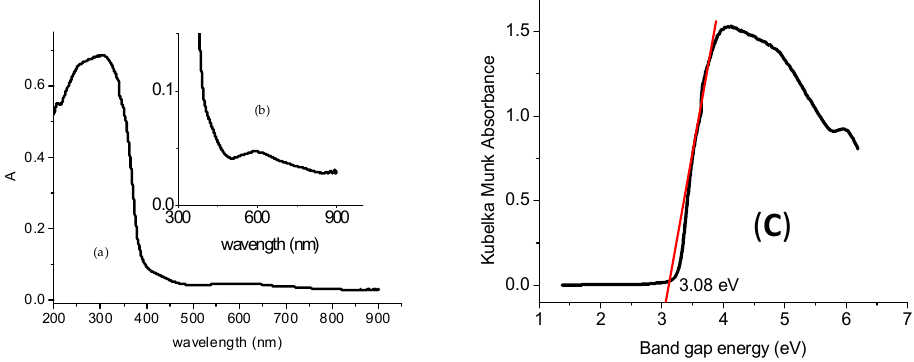
Figure 7. ( a ) UV–Vis diffuse absorption spectra of TiO 2 /Au; and ( b ) Additional peak shoulder in the visible region; and ( c ) Tauc plot for band gap determination of TiO 2 /Au NSs.